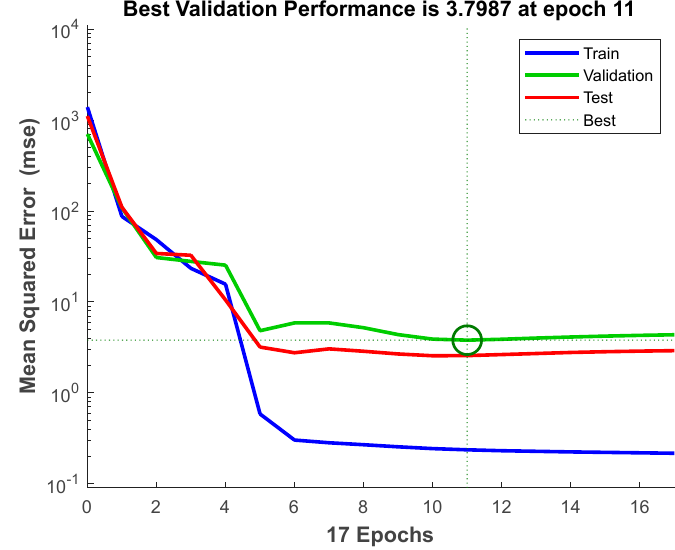
Figure 12. ANN Performance based on the mean squared error metric.